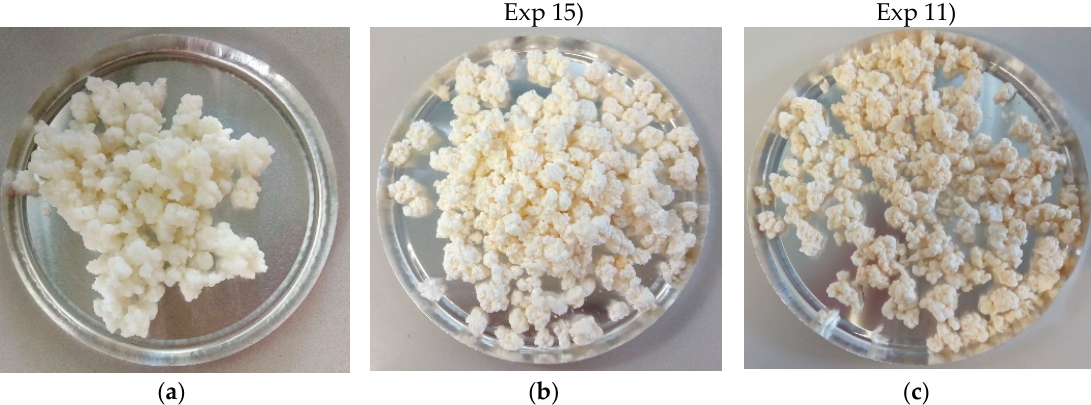
Figure 4. Visual color images of MKG: ( a ) fresh and dried MKG in ( b ) Experiment 15 (least change in color) and ( c ) Experiment 11 (most change in color).